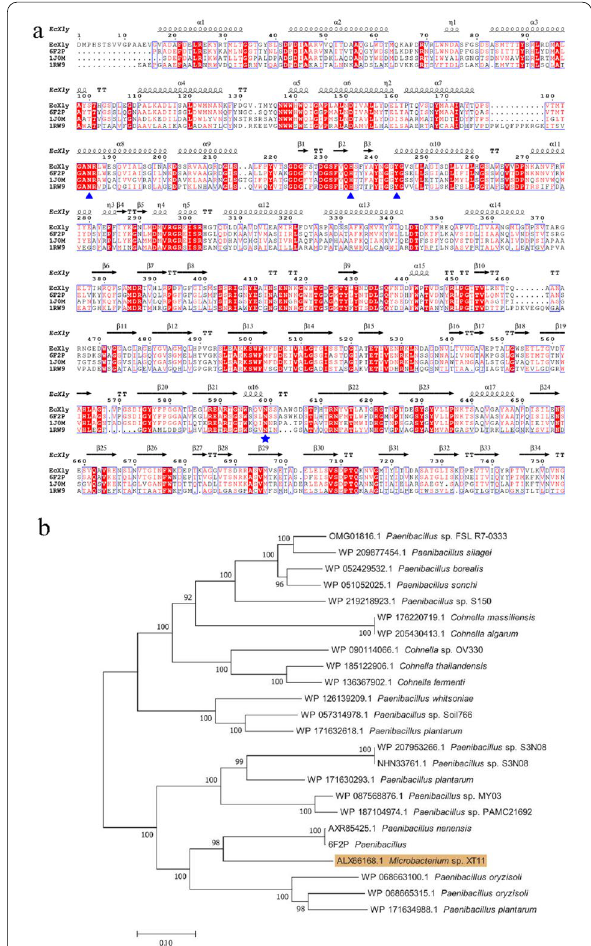
Fig. 3 Sequence, structure and phylogenetic tree analyses of Ec Xly. a Alignment of amino acid sequences of Ec Xly, 6F2P, 1J0M, and 1RW9. The amino acid residues that are conserved in all four proteins, are denoted with white letters and highlighted in red. The amino acid residues that are conserved in two or three different proteins are denoted with red letters. The catalytic active site N 185 , H 235 and Y 244 was labeled as a blue triangle below the residues, and the glycosylation site N 599 was indicated by blue star. b Phylogenetic tree of Ec Xly using MEGA 7.0. Bootstrap values are indicated at branching